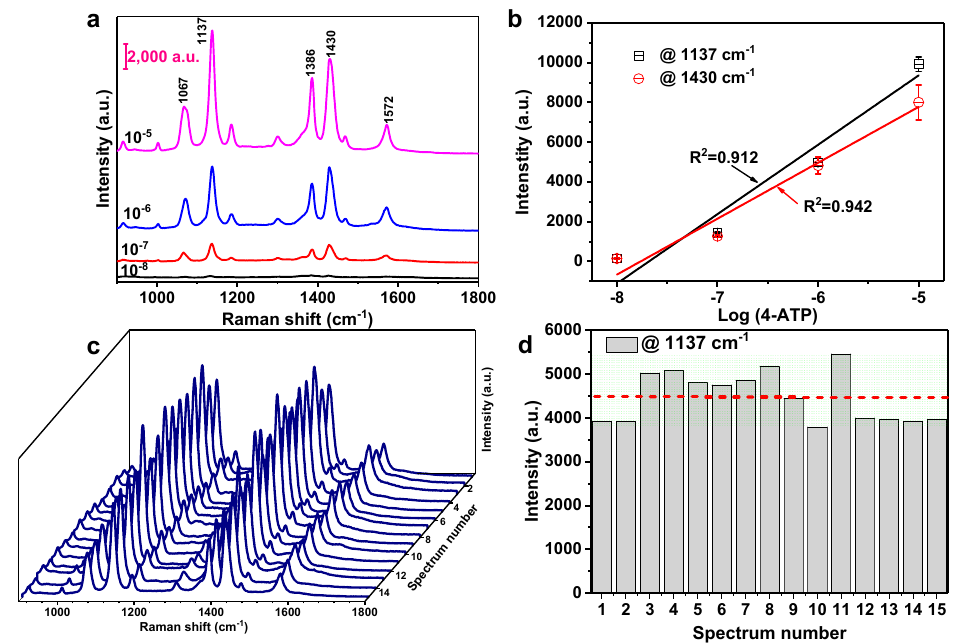
Figure 7. ( a ) SERS spectra of 4-ATP with di ff erent concentrations adsorbed on the same silver nanoaggregates-based substrate prepared under the irradiation intensity and time of 4.5 × 10 5 W / cm 2 and 15 min, respectively. ( b ) SERS intensity at 1137 and 1430 cm − 1 for di ff erent concentrations of 4-ATP, the curves represent the linear fit to the experimental data. ( c ) Collected SERS signals of 4-ATP with the concentration of 10 − 6 M at 15 randomly selected positions. ( d ) Spot-to-spot intensity variation of the characteristic peak at 1137 cm − 1 for the silver nanoaggregates-based substrate. The power of the excitation laser was 38.2 μ W, and the acquisition time was 10 s for each spectrum.